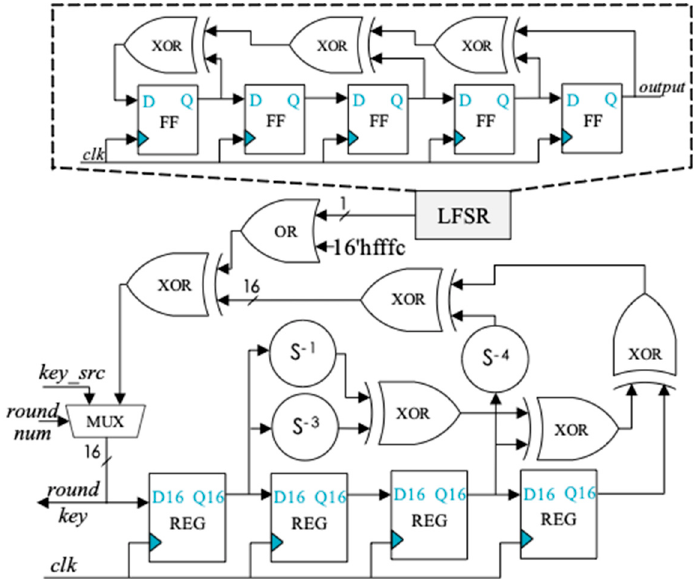
Figure 1. Key generation circuit structure of SIMON 32/64.